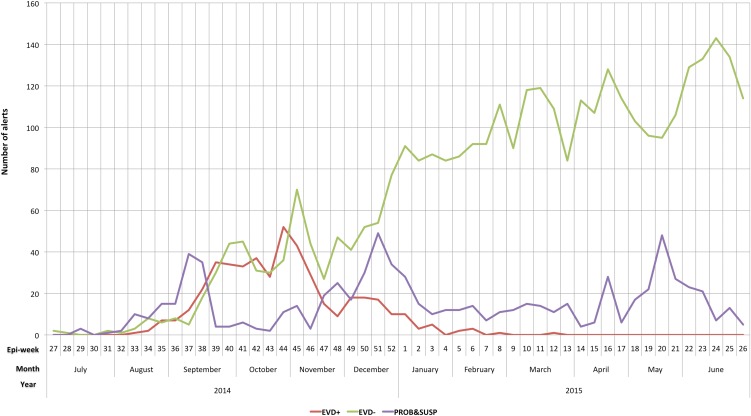
Number of alerts by epi-week, months, year and EVD case definition. Tonkolili, Sierra Leone, 1 July 2014–30 June 2015 (n = 4550). EVD+, Ebola laboratory-confirmed cases; EVD−, Ebola laboratory-excluded cases; PROB and SUSP, Ebola probable and suspected cases.